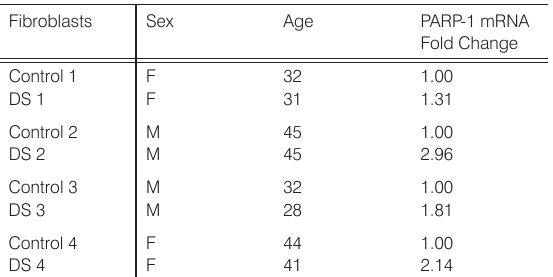
Table 1. Quantitative Real Time PCR analysis of the PARP-1 gene in fibroblasts of subjects with Down syndrome (DS) com - pared with normal subjects